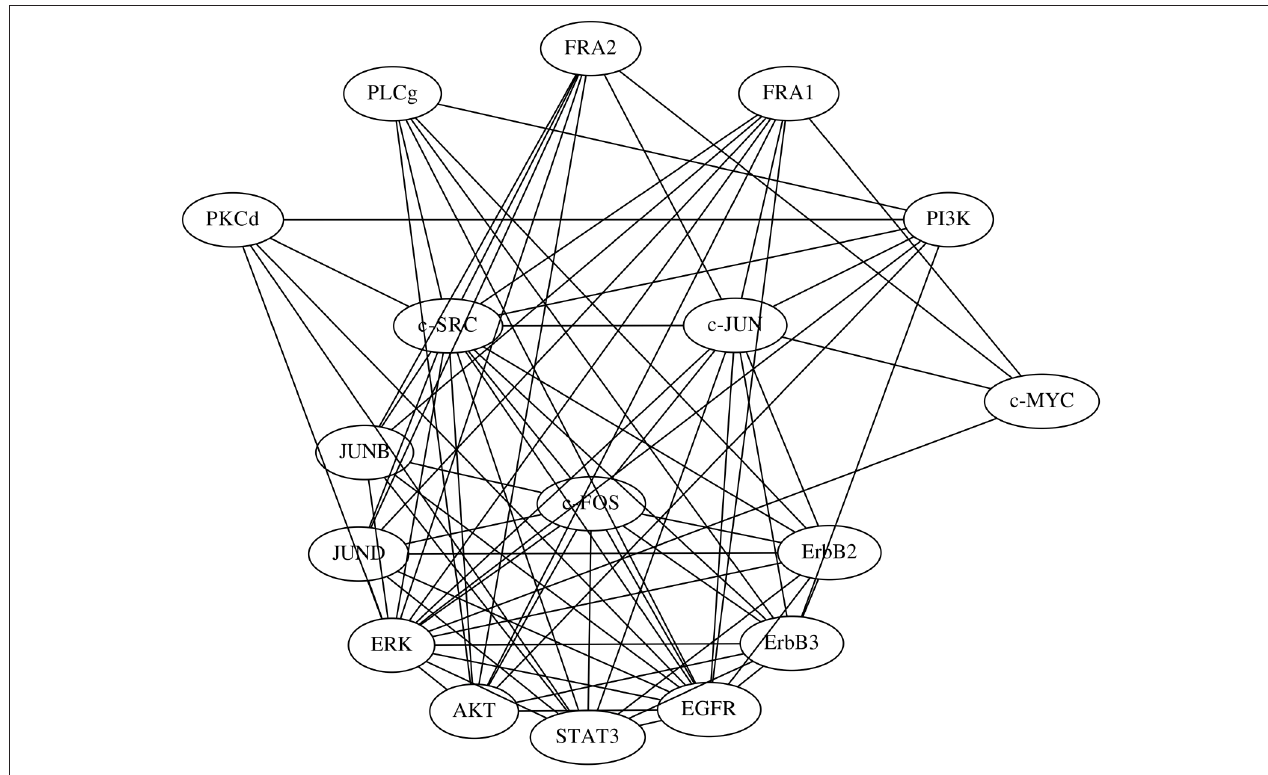
FIGURE 7 | The protein network obtained from the STRING database. Edges represent protein-protein interactions that have been reportedly confirmed by biochemical experiments.